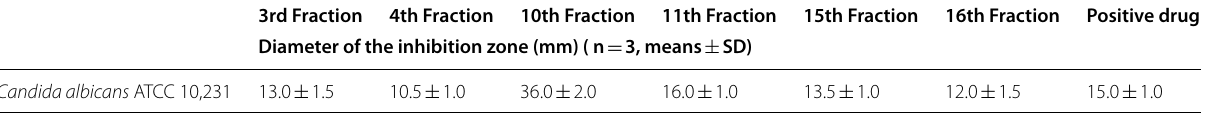
3rd Fraction Diameter of the inhibition zone (mm) ( n